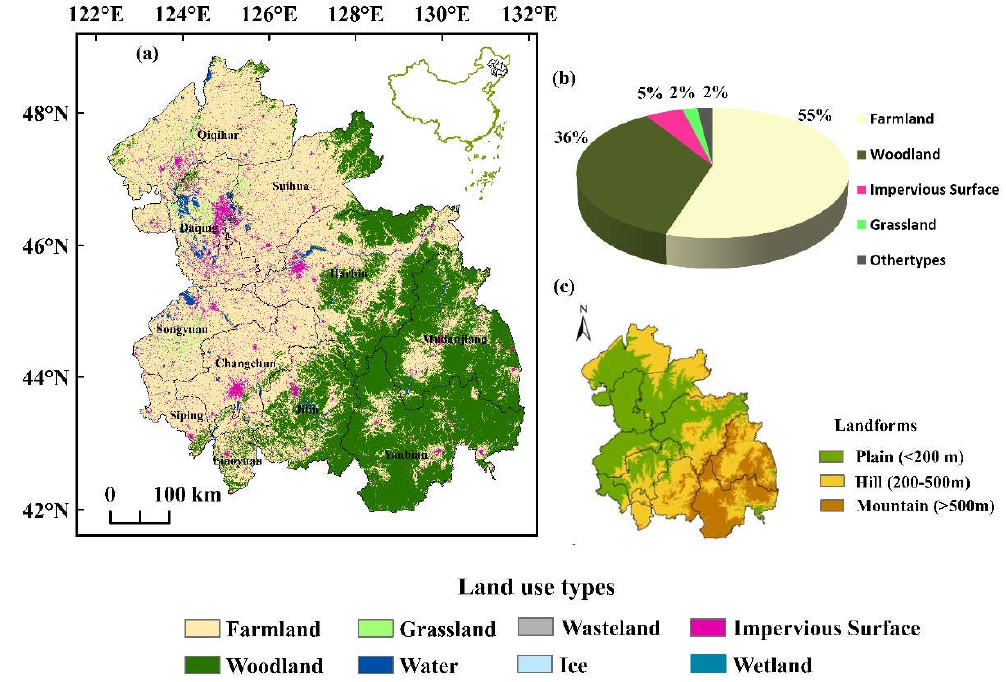
Figure 1. ( a ) The land-use type and ( b ) distribution and ( c ) landforms of the study area.